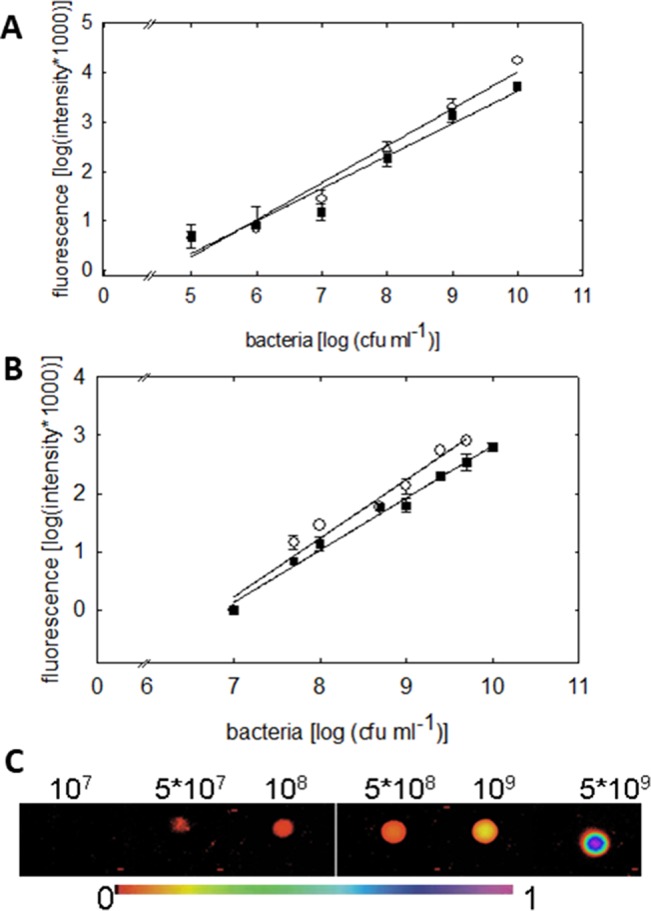
Quantification of the green fluorescence intensity emitted by P. syringae DC3000_gfp (○) or DC3000rpm_gfp (▪) cells. (A) Fluorometric quantification of cells in six different concentrations, from 1 × 105 up to 1 × 1010 cfu ml−1, is shown. The fluorescence signal shows linear dependency on the concentration of the bacteria (R = 0.982; y = 0.748x − 3.468 (DC3000) and R = 0.9750; y = 0.656x − 2.937 (DC3000rpm); n = 4 ± 2). (B) Quantification of green fluorescence intensity by imaging PAM. The fluorescence was measured by imaging PAM from 20 µL of P. syringae cells in 10 mM MgCl2 in increasing concentrations. The fluorescence signal shows linear dependency on bacterial concentration; R = 0.98; y = 1x − 6.8 (DC3000) and R = 0.99 = 0.99; y = 0.89x − 6.12 (DC3000rpm); n = 4 ± 1. In (C), an example of fluorescence signals in various P. syringae concentrations is shown (from 1 × 107 up to 5 × 109 cfu ml−1) detected by imaging PAM. The false scale color is given in the bottom.